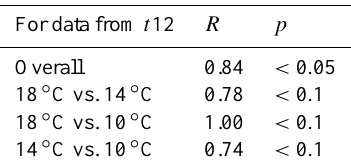
Table 2. Results of a one-way ANOSIM of the effects of tempera- ture on biogeochemical parameters (DIC, POC, DOC, NO 3 , PON and DON) at the time of the peak of the plankton bloom (day t 12), including pairwise tests for differences between temperature treat-